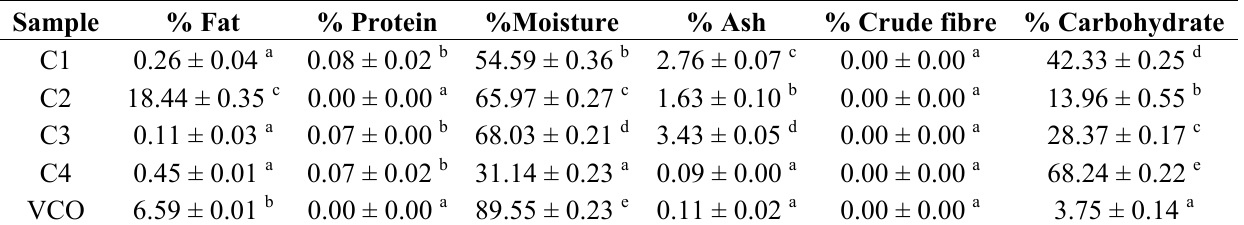
Table 1. Proximate analysis of the commercial emulsion samples and virgin coconut oil emulsion. Sample